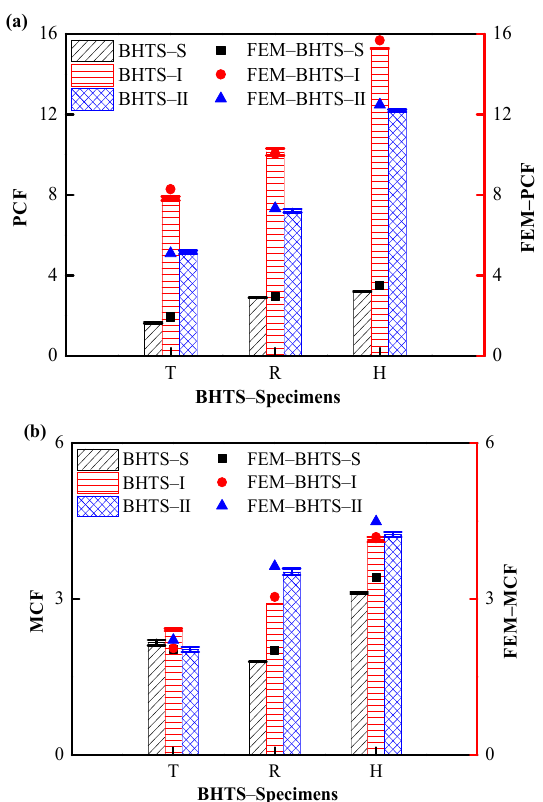
Figure 10. Statistics of PCF and MCF corresponding to different section angles: ( a ) PCF; ( b ) MCF.